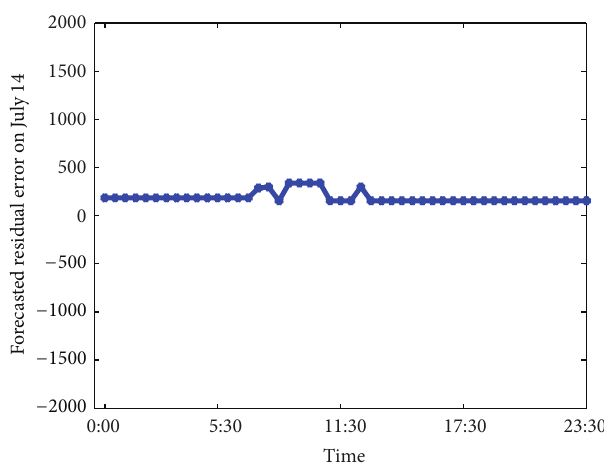
Figure 8: Residual error on July 14 forecasted by the BP neural network.